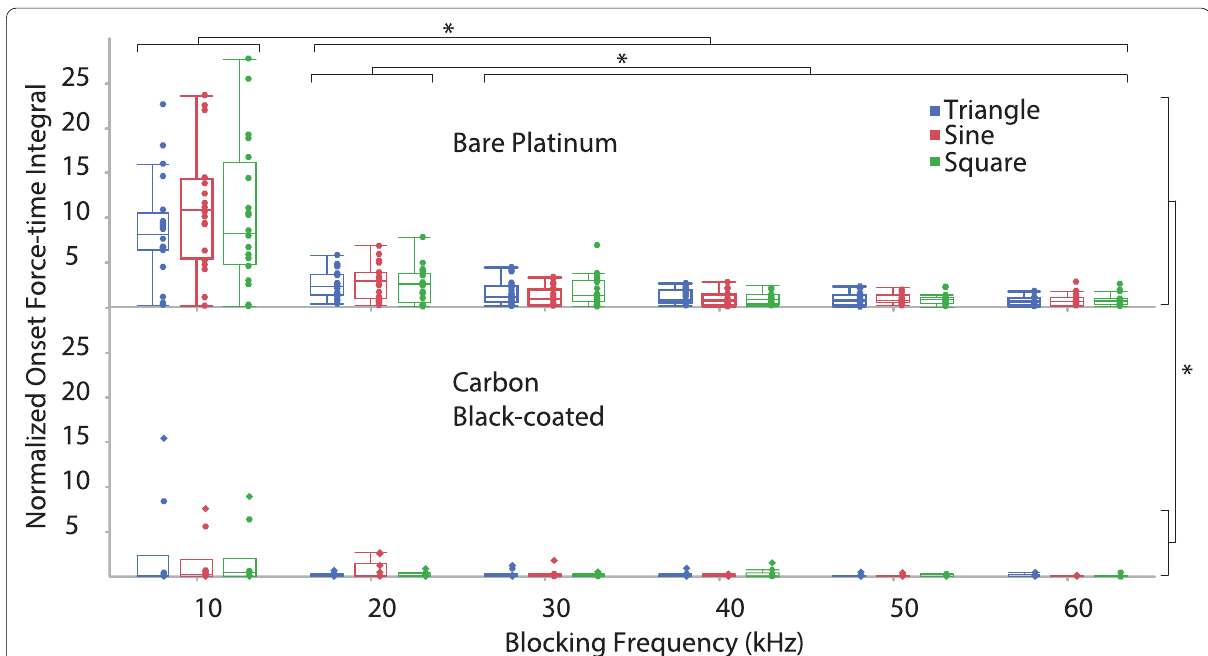
Fig. 9 Onset responses for the force-time integral for both electrode types. Onset response was significantly affected by blocking frequency ( p < 0.001) but not waveform shape. Responses to 10 kHz were significantly larger than all other frequencies (* p < 0.001). Responses to 20 kHz were significantly larger than all frequencies greater than 20 kHz (* p < 0.001)